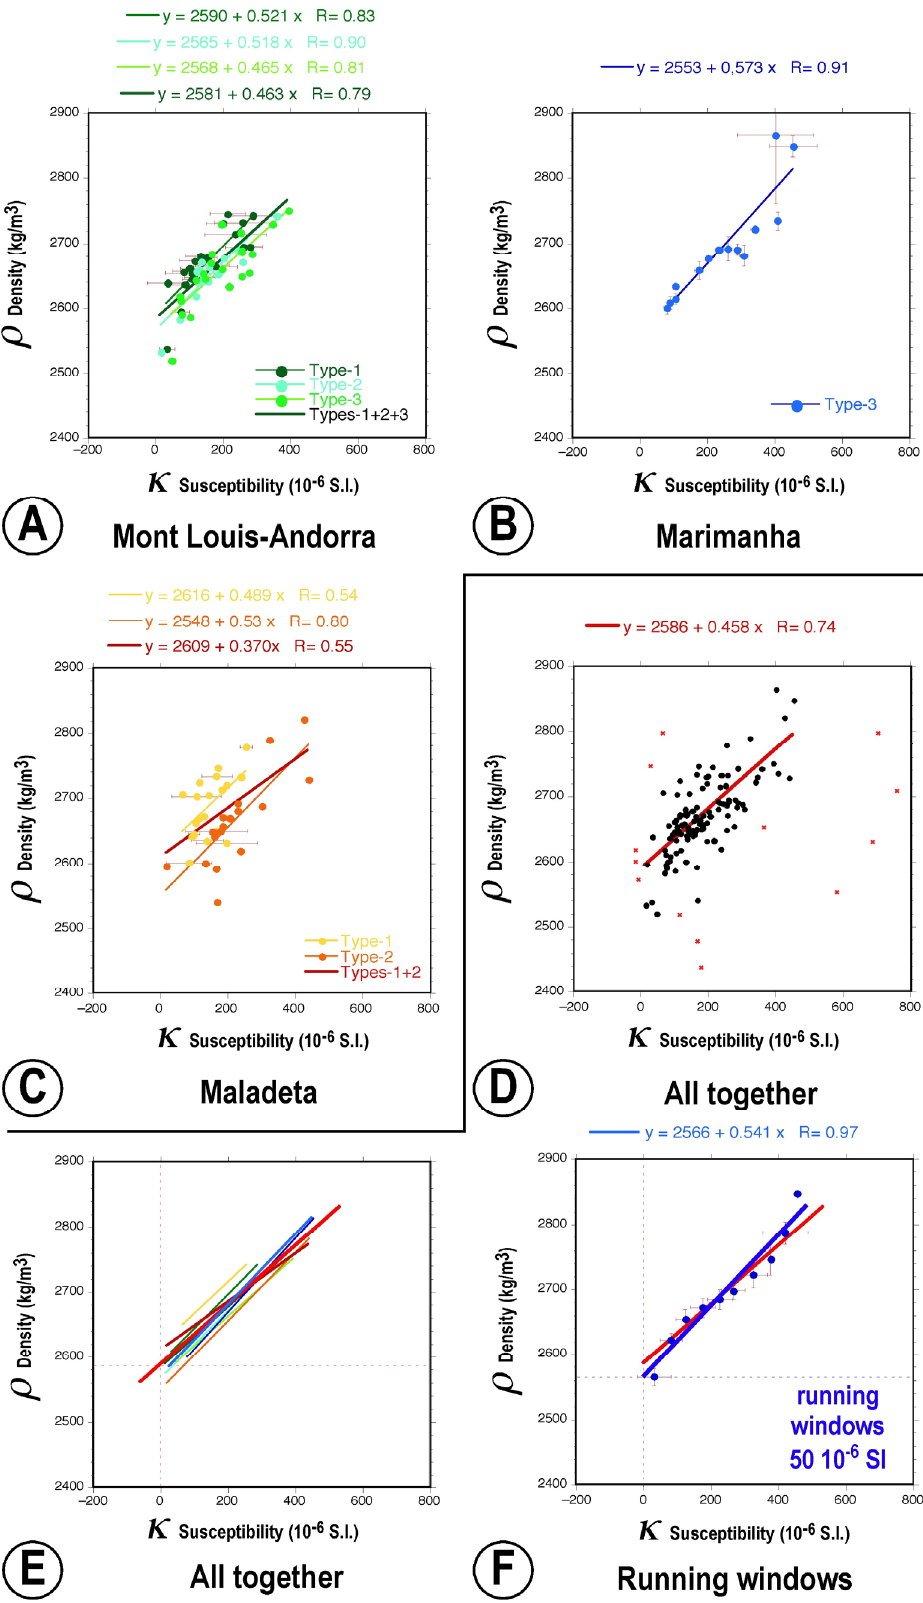
Figure 9. Density versus magnetic susceptibility graphs and regressions. ( A – C ) pluton by pluton (sample types are differentiated by different colors). ( D ) All data together, outliers (in red) are excluded for the calculation. ( E ) All regressions together plus the running window averages ( F ).